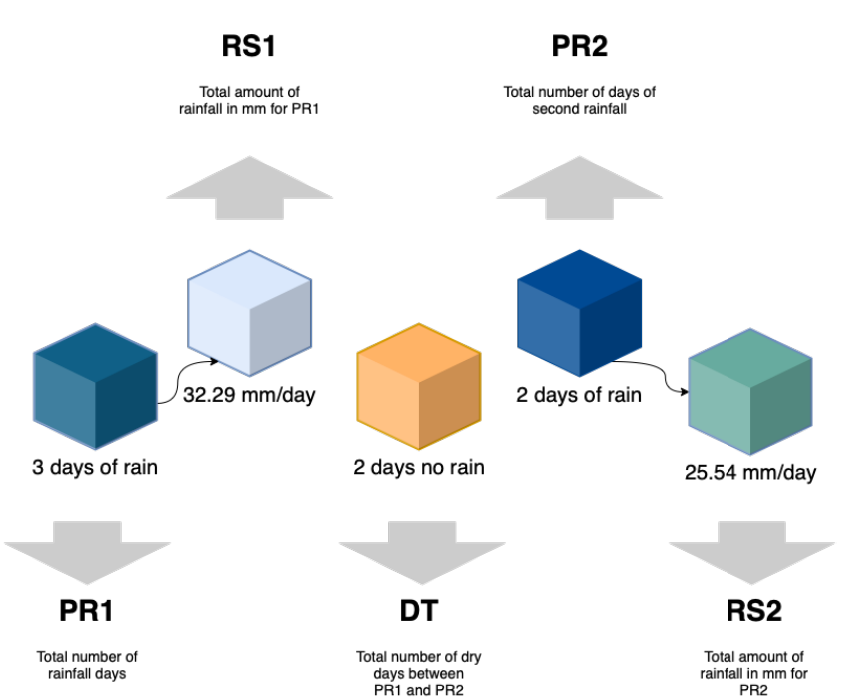
Figure 4. An example of rainfall characteristics for two successive rainfall/dry periods at one landslide location. PR1 and RS1 represent the very first rainfall recorded at one location: (PR1) number of days that the rainfall (intermittently lasted) and (RS1) the total amount of rainfall in that period. Then, there was no rain for 2 days (DT), but later it rained for 2 extra days (PR2) amounting to the triggering rainfall (RS2). These rainfall/dry pairs start at the beginning of the rainfall time series (01/01/2016) until the time of the landslide as listed in the inventory. Each pair is stored as a “running” data line where PR2 and RS2 become PR1 and RS1 of the following line. Table 2. Variables created to track rainfall days, dry days, and rainfall amounts leading to a land- slide event in the inventory.